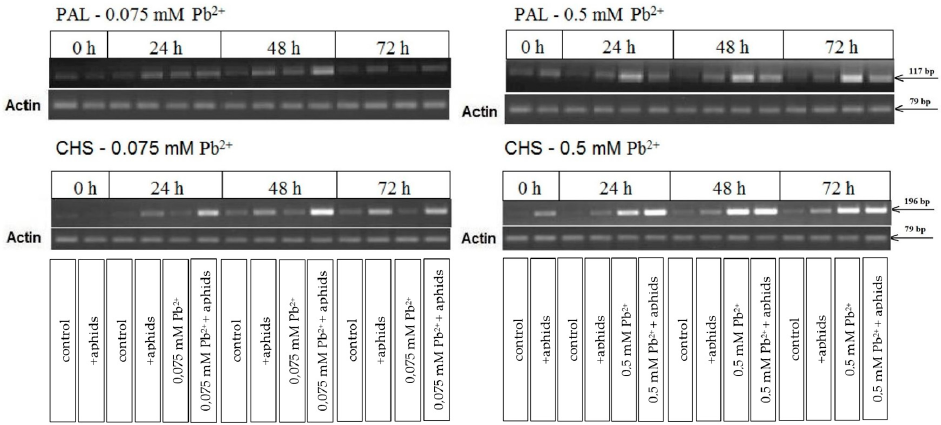
Figure 6. The effect of lead and A. pisum on expression levels of phenylalanine ammonialyase (PAL) and chalcone synthase (CHS) genes in leaves of pea seedlings. The data were obtained in three independent experiments and statistically analysed using ANOVA ( p -values at α = 0.05). Hypotheses on the equality of means were verified by the two-sample t -test. To account for multiple testing, we used the Bonferroni correction (statistically significant differences are shown in Table S1).